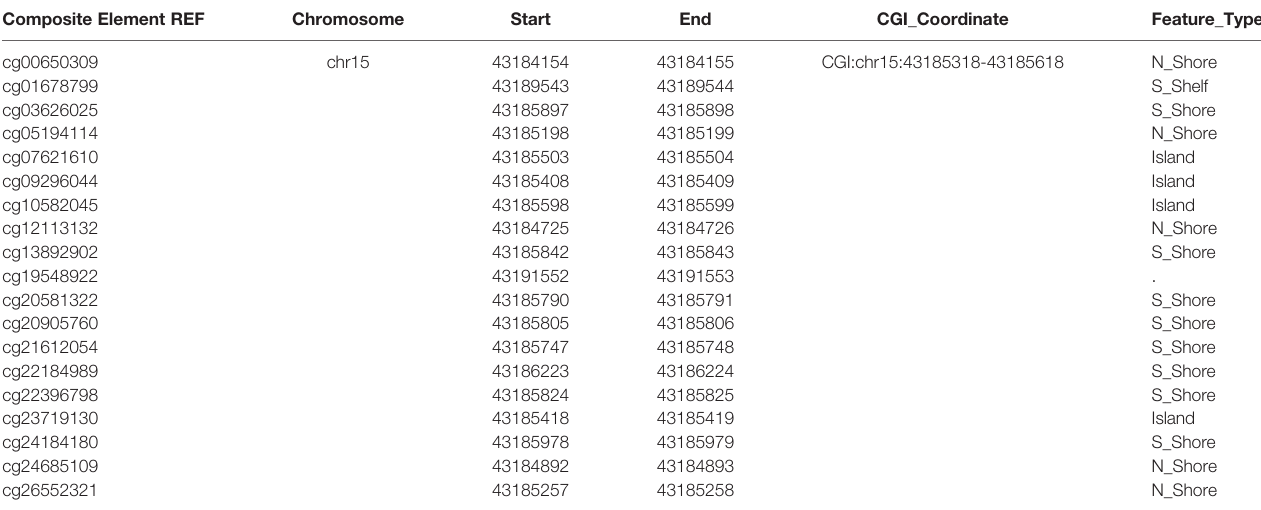
TABLE 5 | The methylation sites of